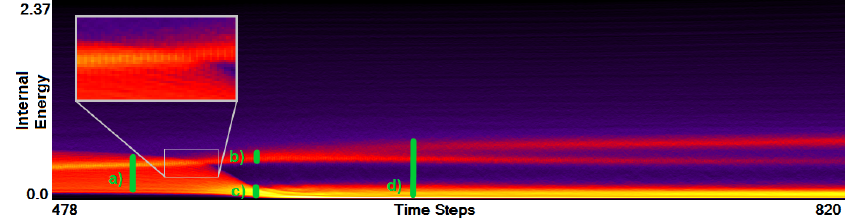
Figure 7. Function plot of the simulation of two stars with different masses equal to 0.65 and 1.05 of the solar mass. Same three phases can be distinguished as in Figure 6, but additional feature can be observed for a hot matter. Interactive selection (shown in green) for coordinated view to the linked physical domain visualization.